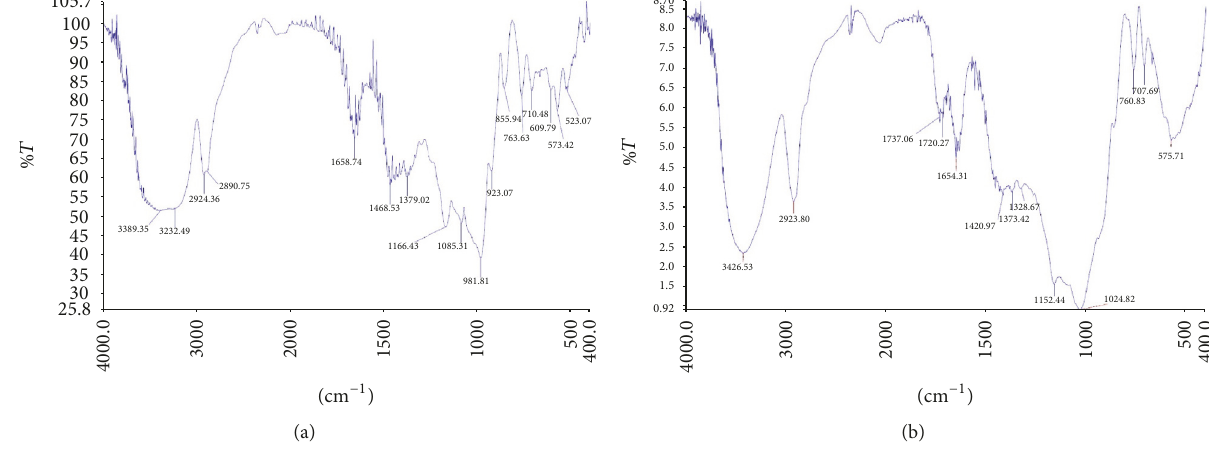
Figure 1: IR spectra of native (a) and modified (b) potato